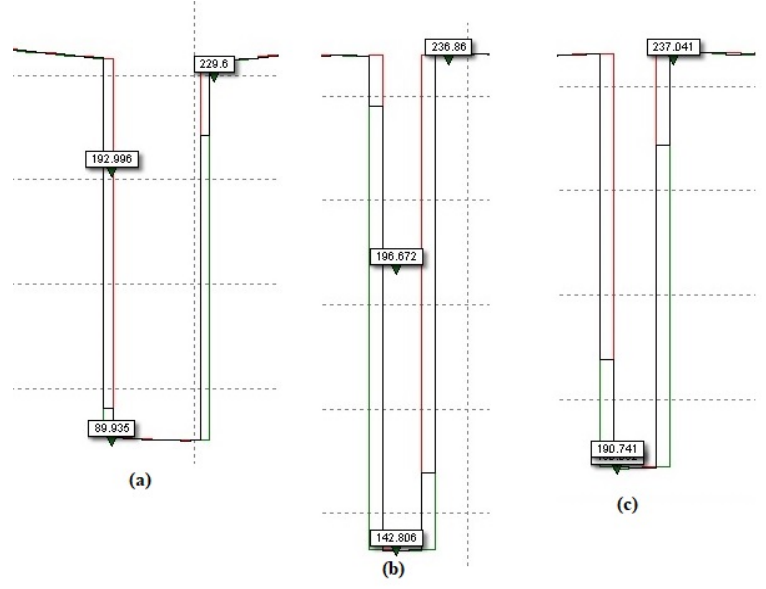
Figure 5. Voltage sag of ( a ) 40%, ( b ) 70%, and ( c ) 80%.